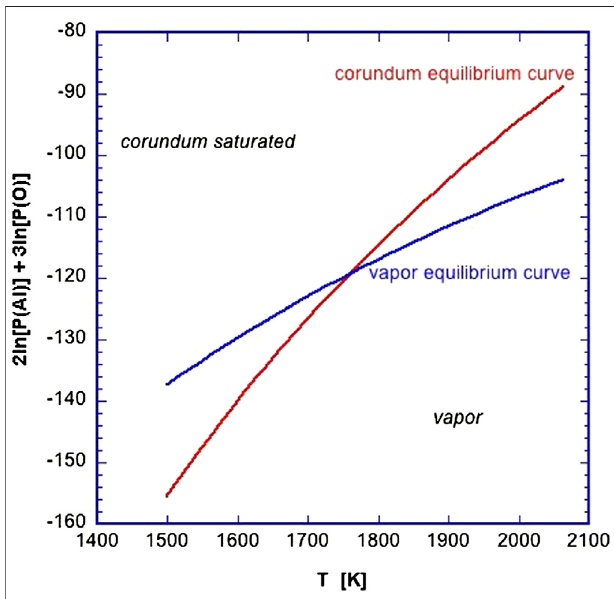
FIGURE 3 | The equilibrium curve describing solid corundum (lefhand side of Eqn. 2 and the vapor equilibria of aluminum and oxygen ( Eq. 3 ) evaluated for solar abundances and a total vapor pressure of 10 – 3 Atm. The two curves intersect at the condensation temperature of corundum, 1758 K for these conditions. See text for more